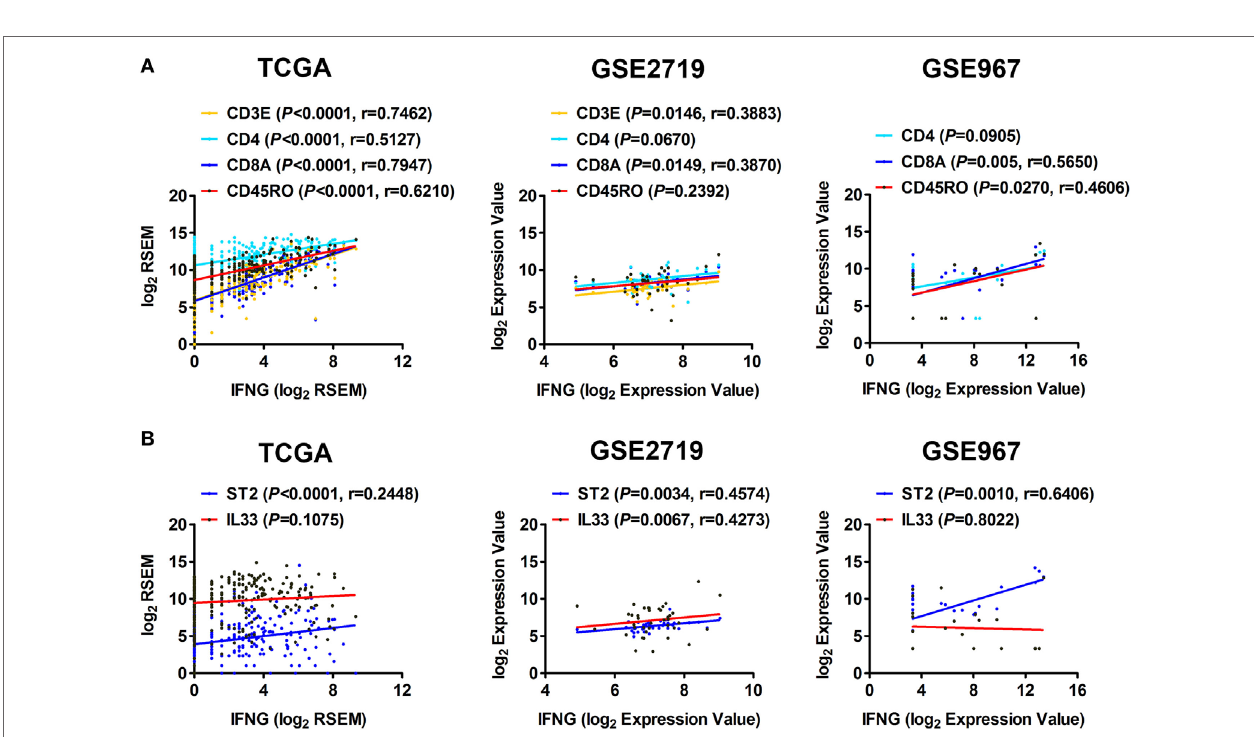
FigUre 3 | Correlation between the expression of ST2 and IFN- γ in soft tissue sarcoma. (a) Positive correlations between the transcriptional levels of IFN- γ and CD3E, CD4, CD8A, and CD45RO by analyzing sarcoma data of The Cancer Genome Atlas, GSE2719, and GSE967. (B) Positive correlations between the transcriptional levels of IFN- γ and ST2, IL-33. The correlation between gene expression levels was analyzed by Pearson correlation test.